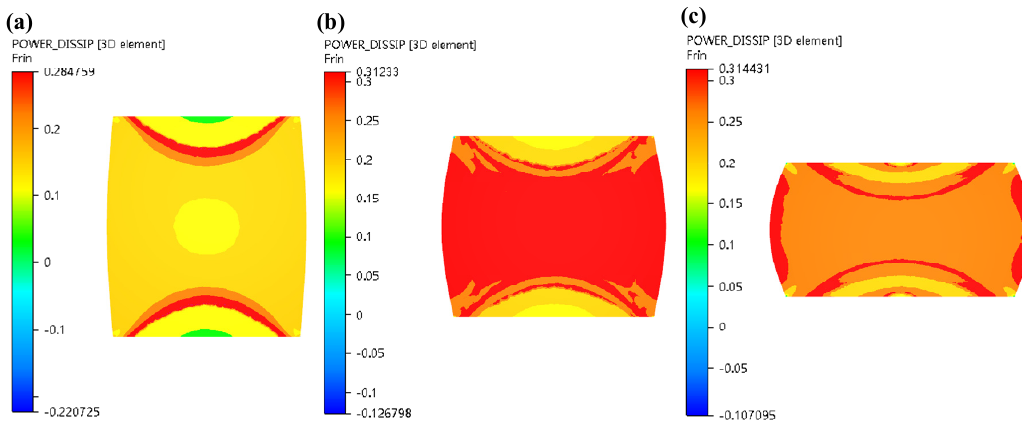
Figure 14. Distributions of η (power dissipation coe ffi cient) in the condition of 1050 ◦ C / 0.1 s − 1 under various strains: ( a ) ε = 0.2; ( b ) ε = 0.4; ( c ) ε = 0.7.